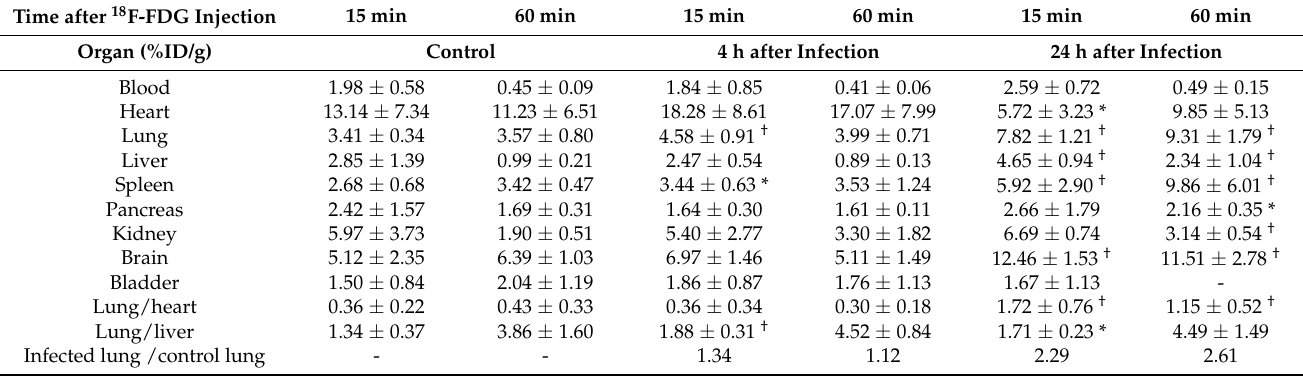
Table 3. Biological distribution of 18 F-FDG in lung-infection-model